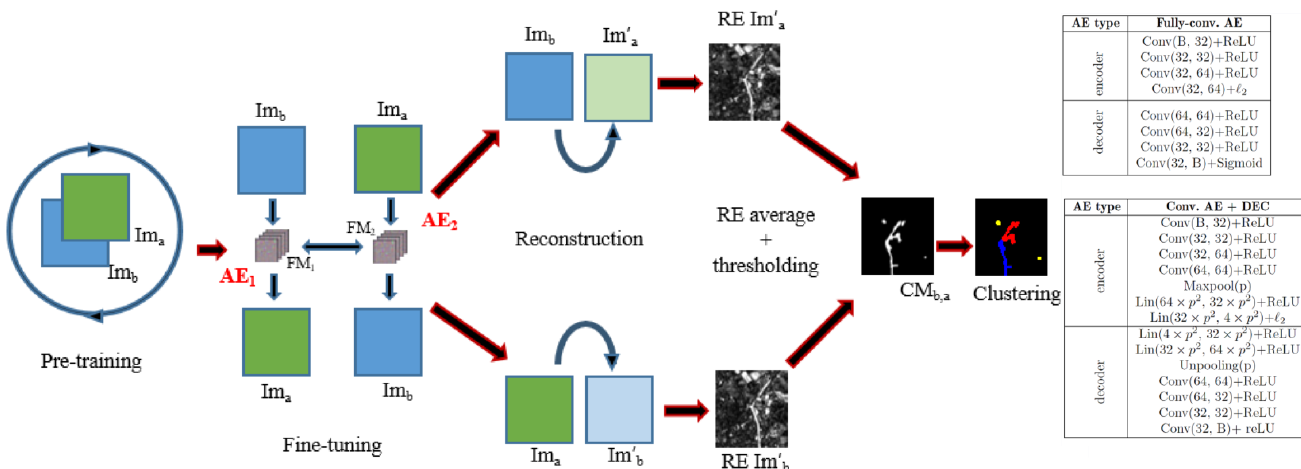
Figure 12. Unsupervised damage assessment architecture proposed by Sublime et al.: On the left, the different steps of the change detection and clustering process. On the right, tables detailing the architecture for their joint-autoencoder and for the Deep Embedding clustering Neural Network. The image is modified from